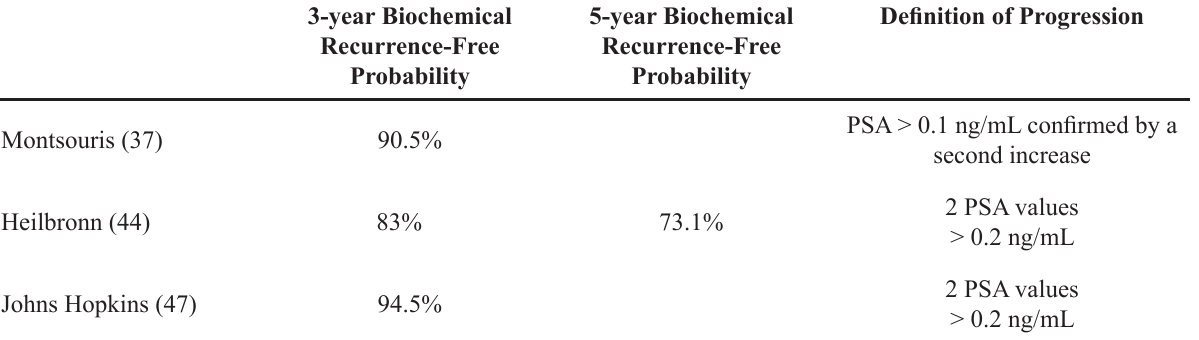
Table 9 – Progression